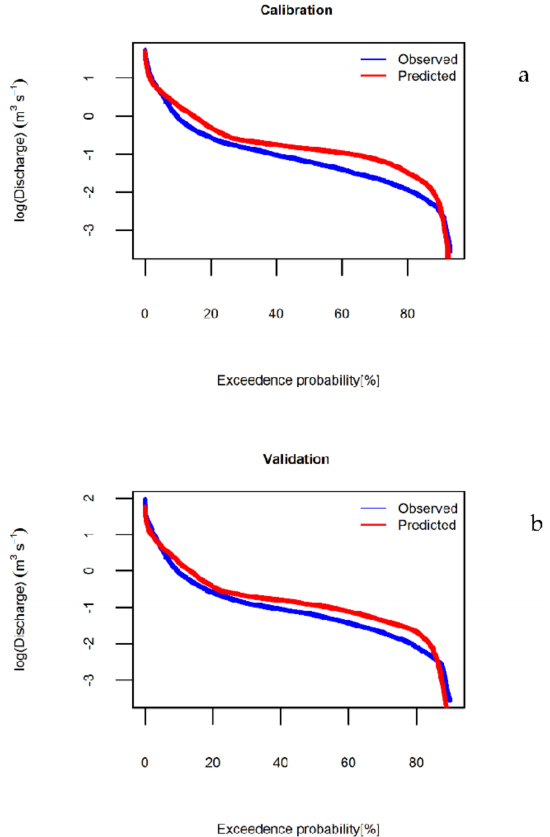
Figure 3. Flow duration curve for calibration ( a ) and validation ( b ) of SWAT model for Goodwater Creek Experimental Watershed at weir